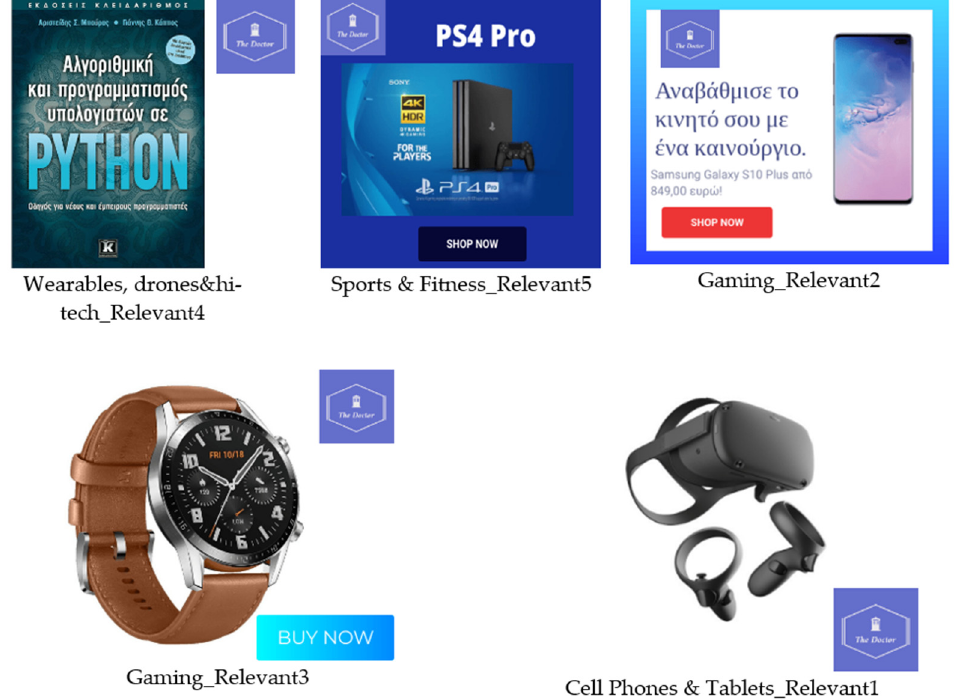
Figure 2. Constructed banner advertisements with relevant content and the category in which they were placed.